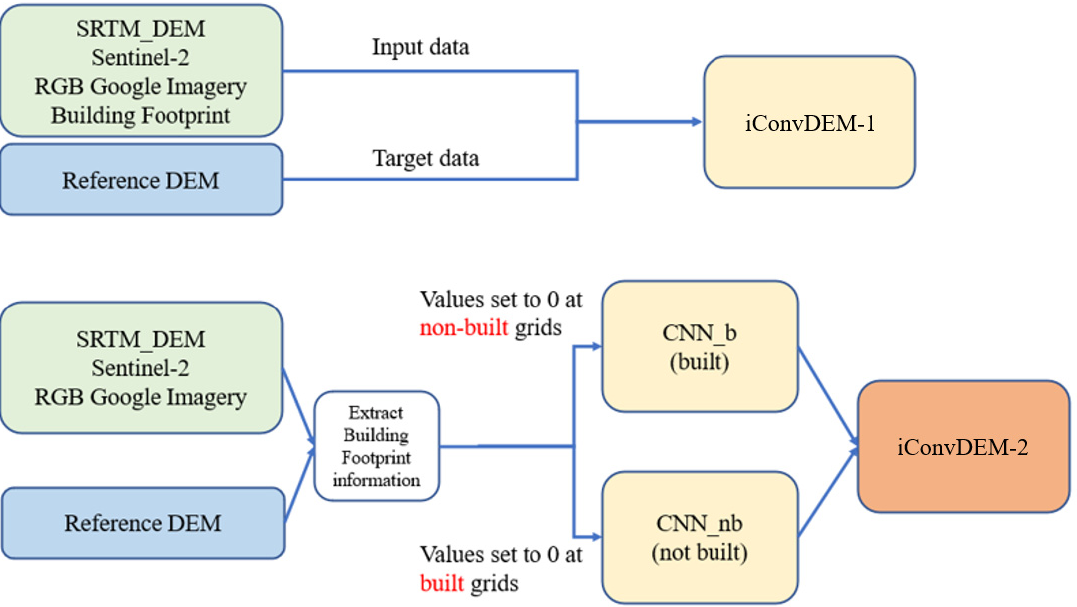
Figure 5. The flowchart of data usage for iConvDEM-1 and iConvDEM-2.